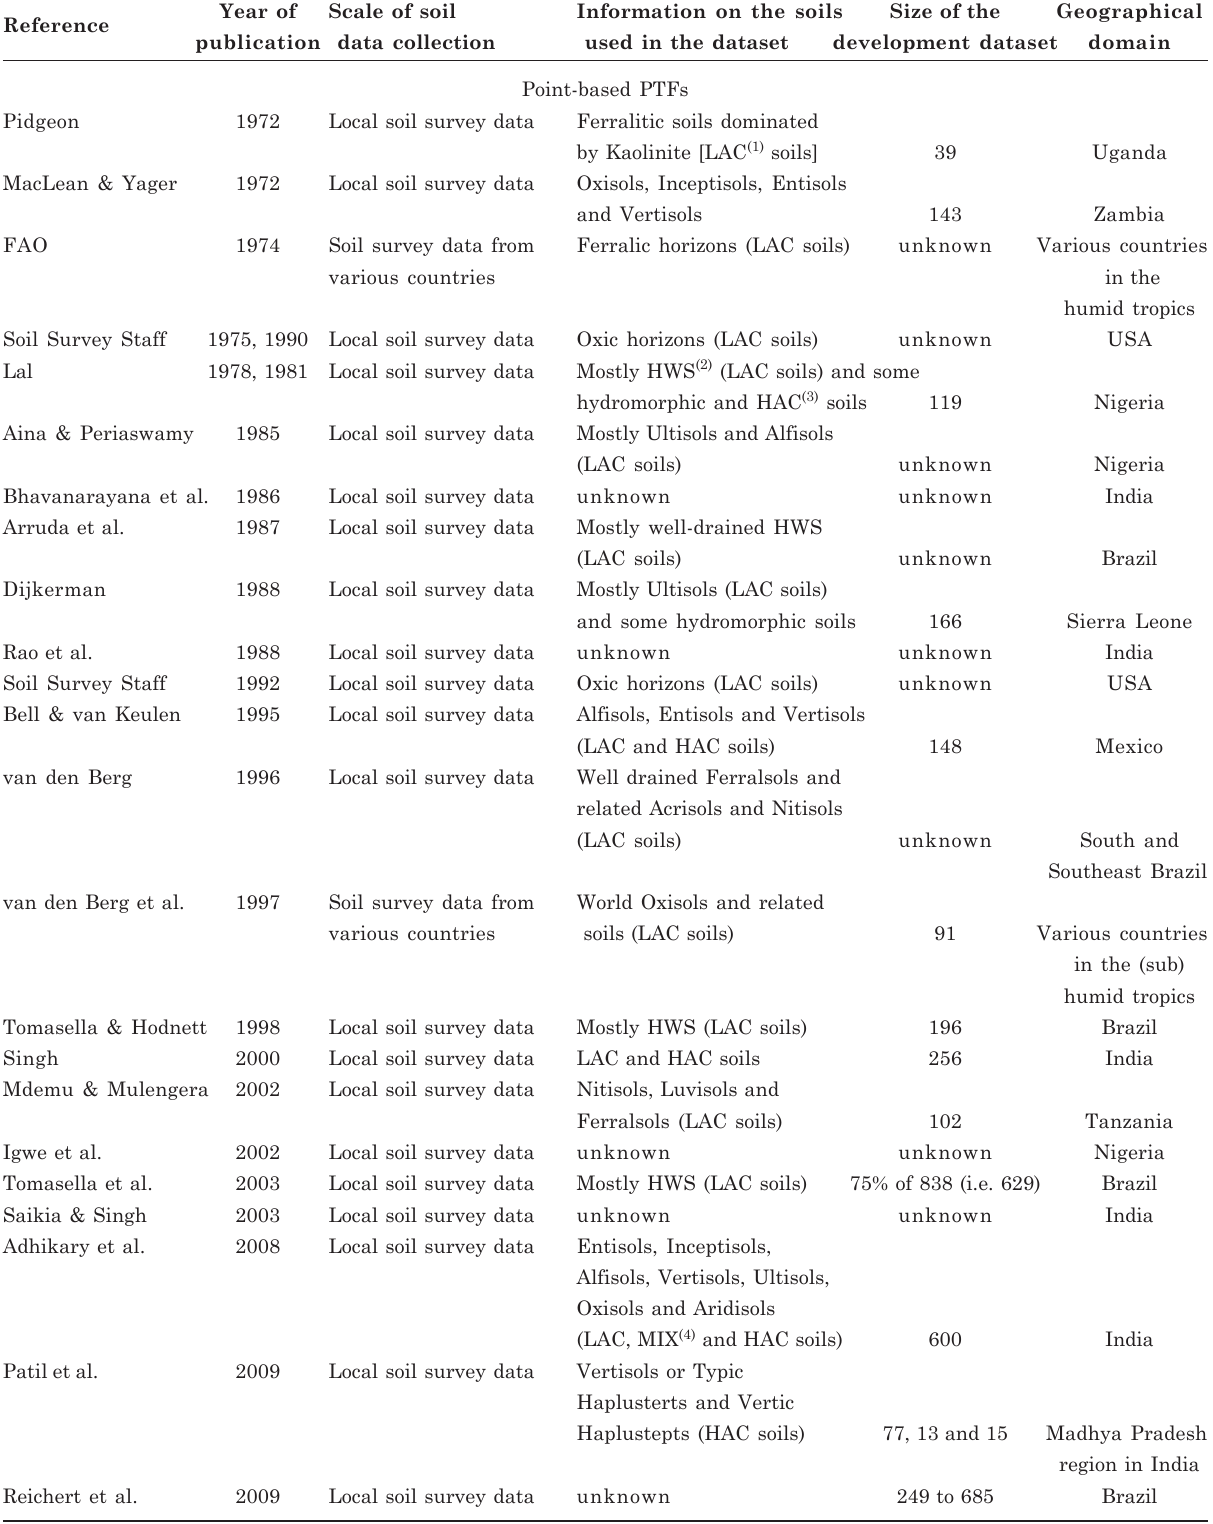
Table 1. General information on point-based, parameter-based, and semi-physical water retention pedotransfer functions (PTFs) developed for soils of the humid